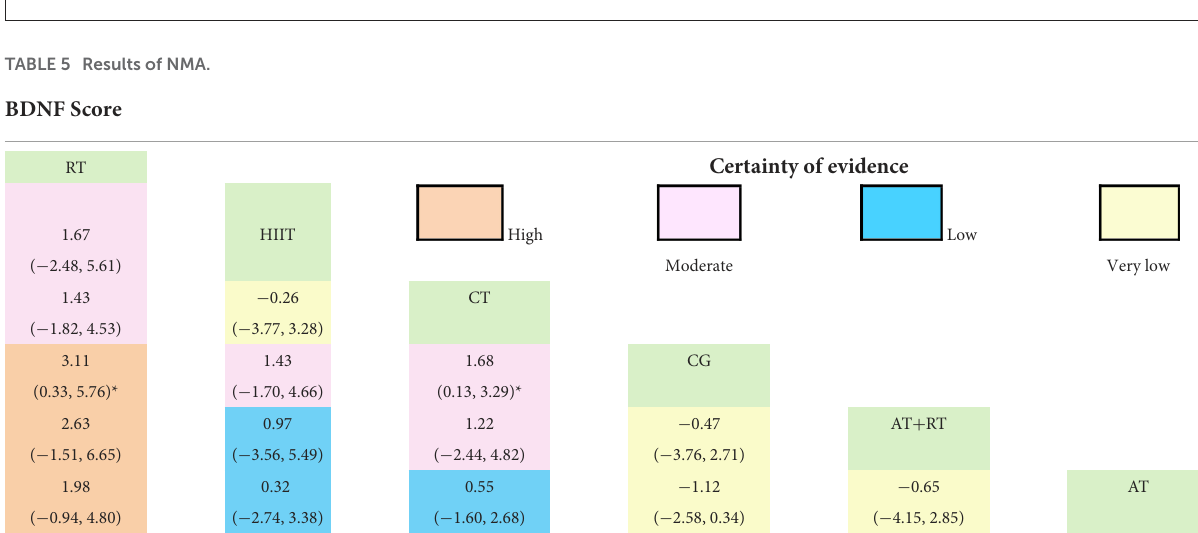
FIGURE4 Probability ranking chart of the effect of five types of exercise on BDNF.